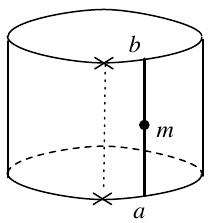
Figure 21 . A morphism m : a ! b de(cid:12)nes an operator Z ( m ) : V a ! V b .